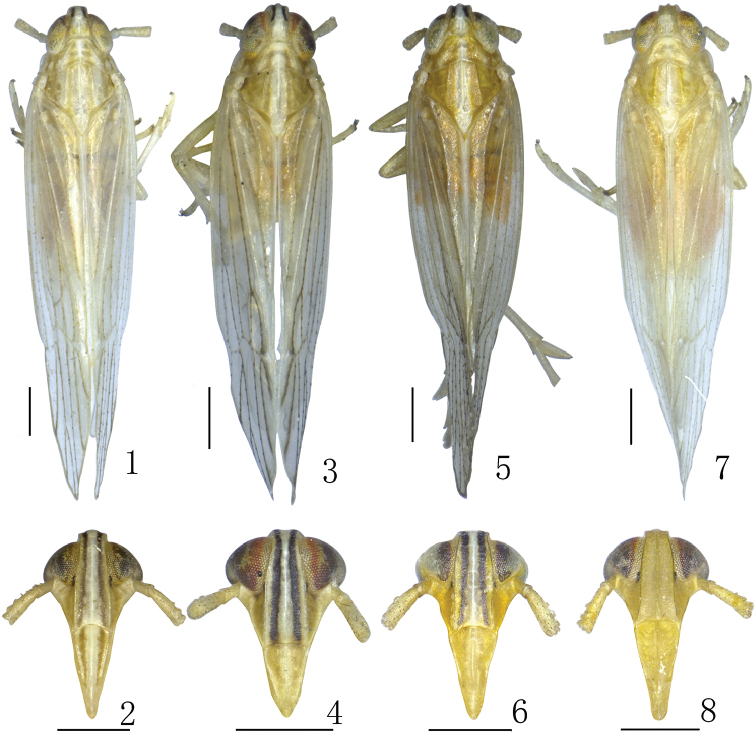
Dorsal and frontal view 1, 2Neometopinapenghuensis Yang, 1989 3, 4Sogatadohertyi Distant, 1906 5, 6Neunkanodesformosana Yang, 1989 7, 8Lisogatazhejiangensis Ding, 2006. Scale bar: 0.5 mm.